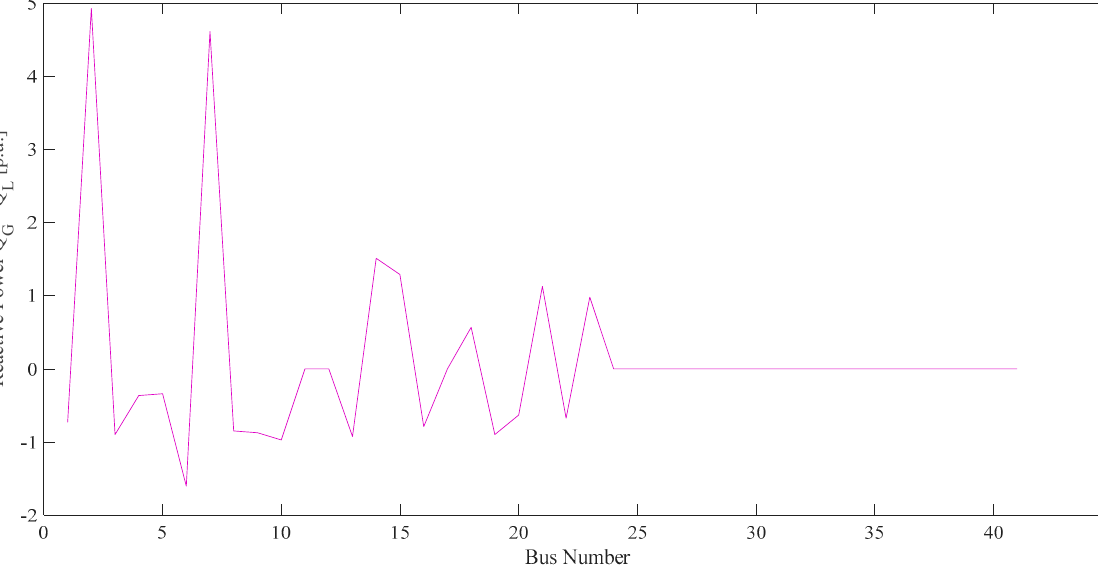
Figure 6. Reactive power output of the uncompensated Nigerian 41 bus transmission network. Table 3. Power flow result of the compensated Nigerian transmission network with IPFC.